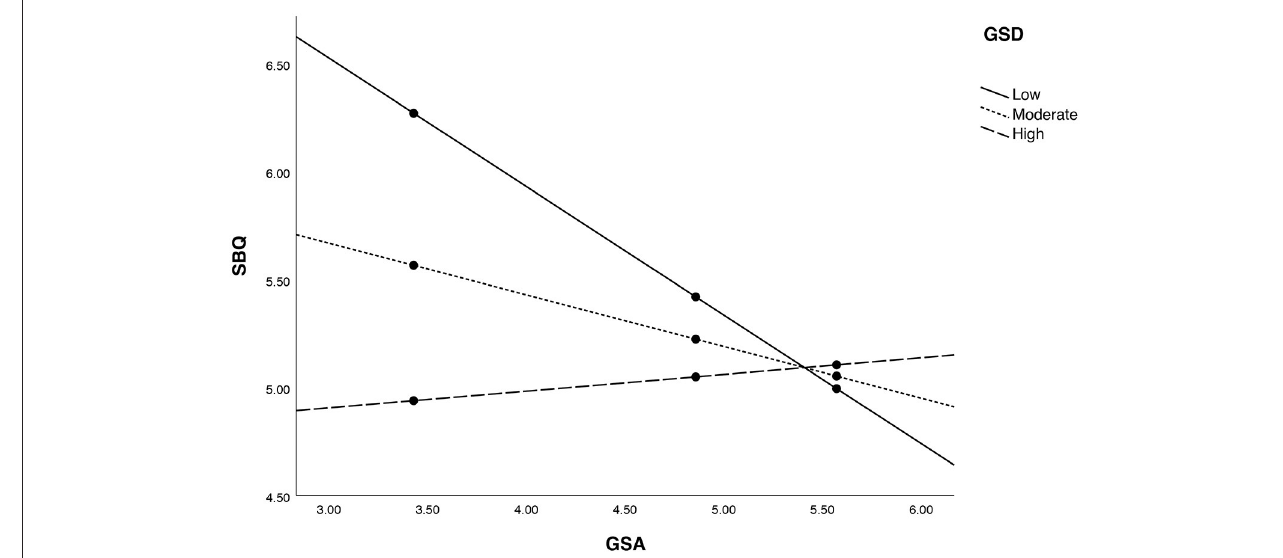
FIGURE 1 | The visual representation of moderation effect.